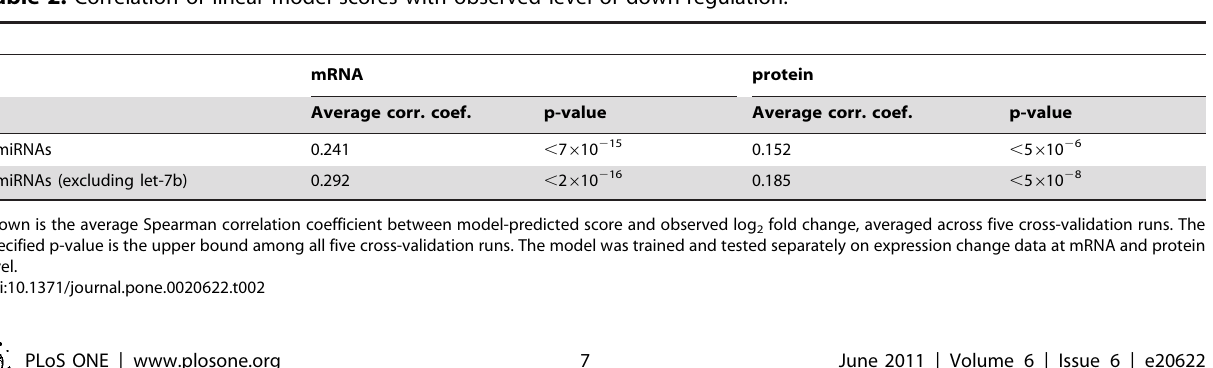
Table 2. Correlation of linear model scores with observed level of down-regulation.